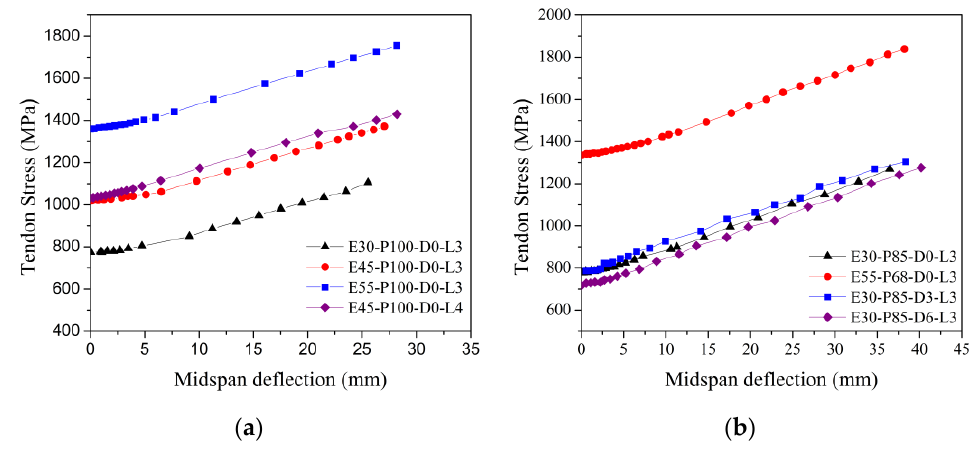
Figure 10. Tendon stress – deflection relationships of specimens: ( a ) fully prestressed specimens; ( b ) partially prestressed specimens. ( b ) partially prestressed